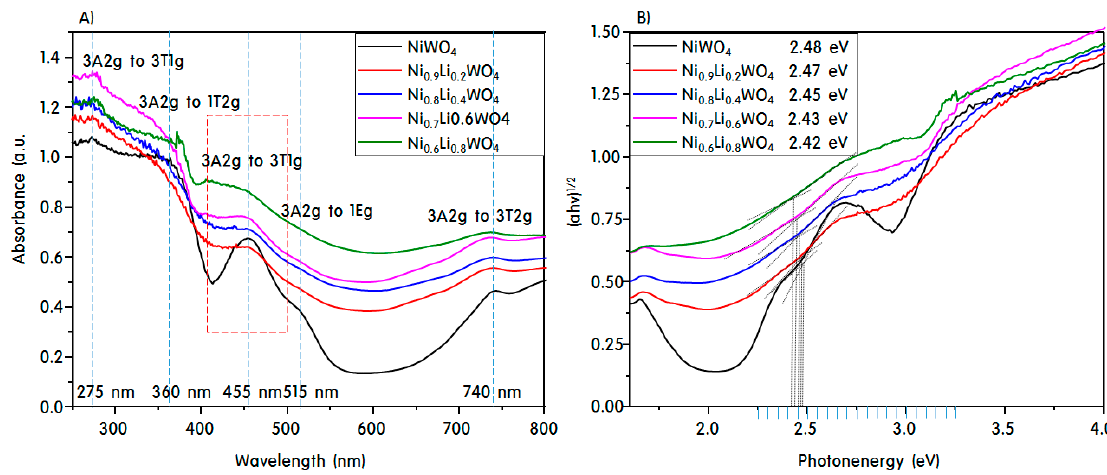
Figure 5. UV-vis DRS spectra A ) and Tauc plots B ) of the NiWO 4 and Ni 1-x Li 2x WO 4 particles.